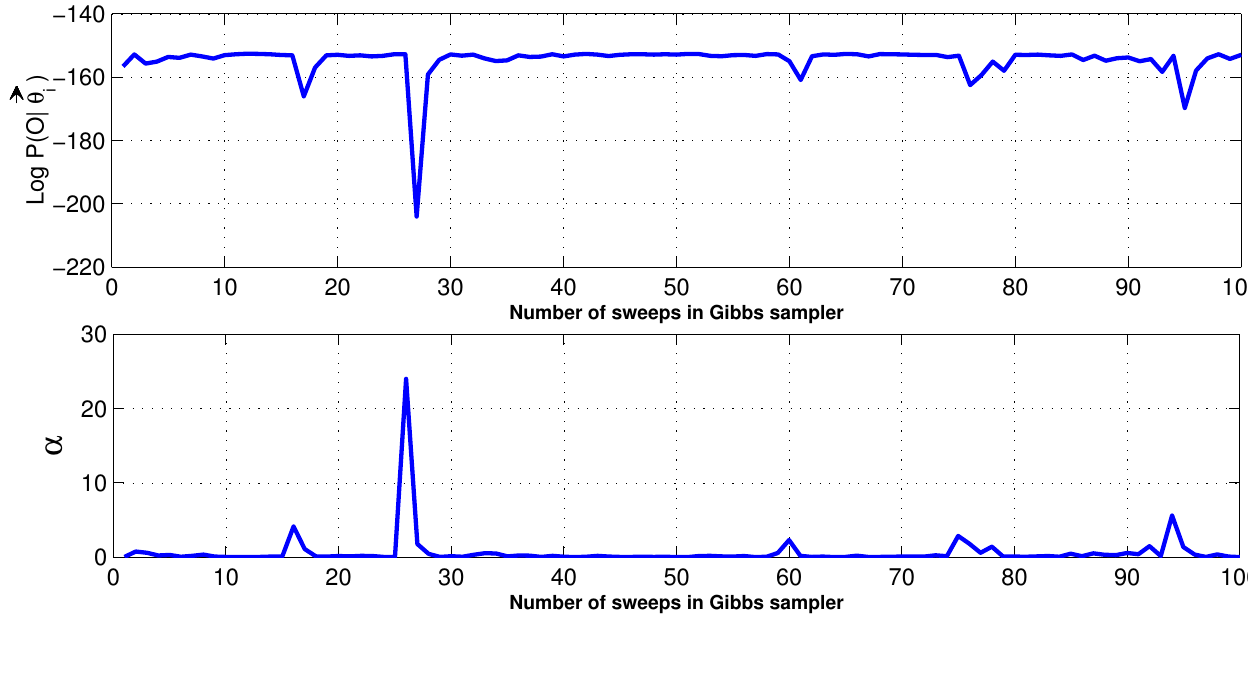
Figure 11. Convergence characteristics of the collapsed Gibbs